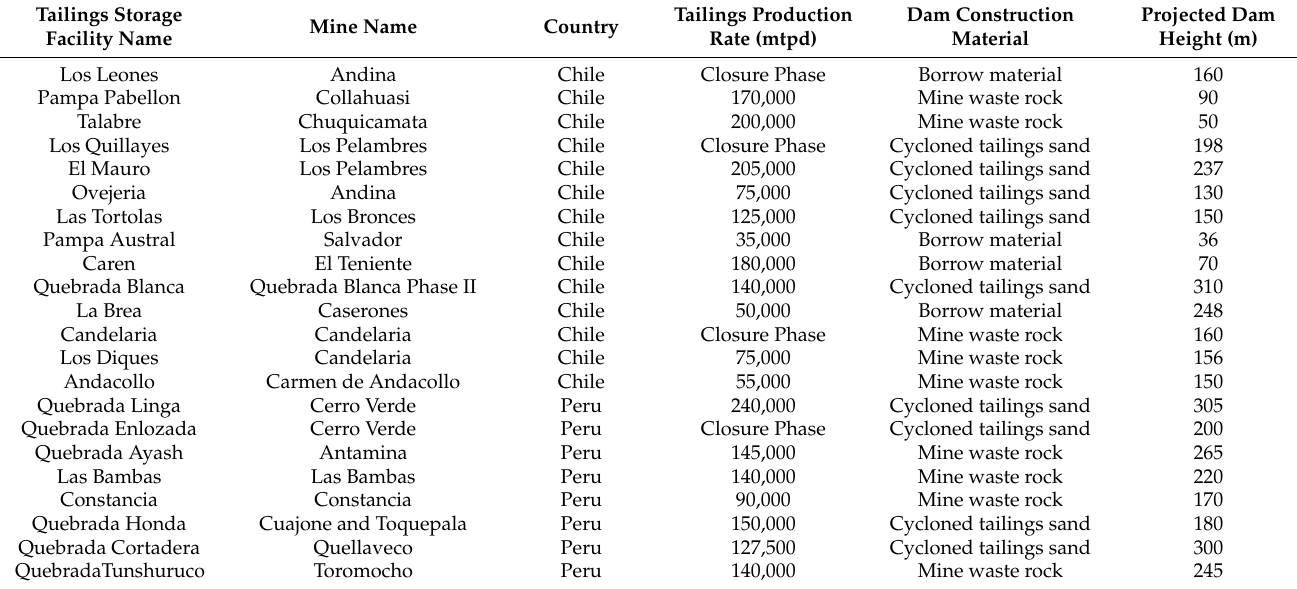
Table 1. Characteristics of tailings storage facilities with the highest dams in the world—mining projects in Chile and Peru